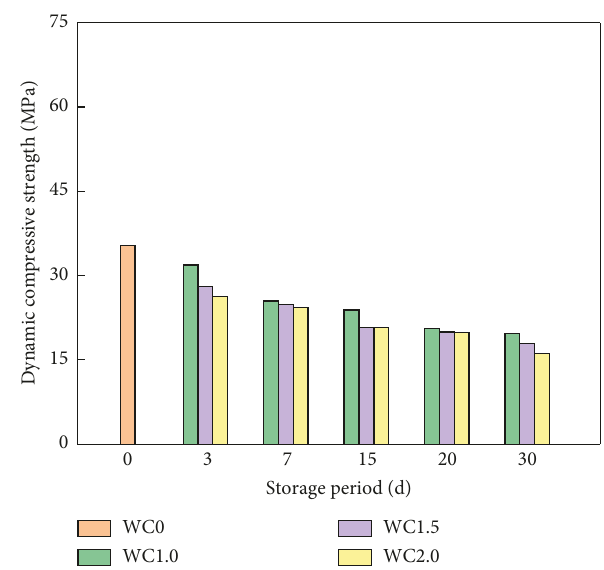
Figure 6: Dynamic compressive strength of ready-mixed concrete specimens with 0.6MPa impact pressure in uniaxial load state.